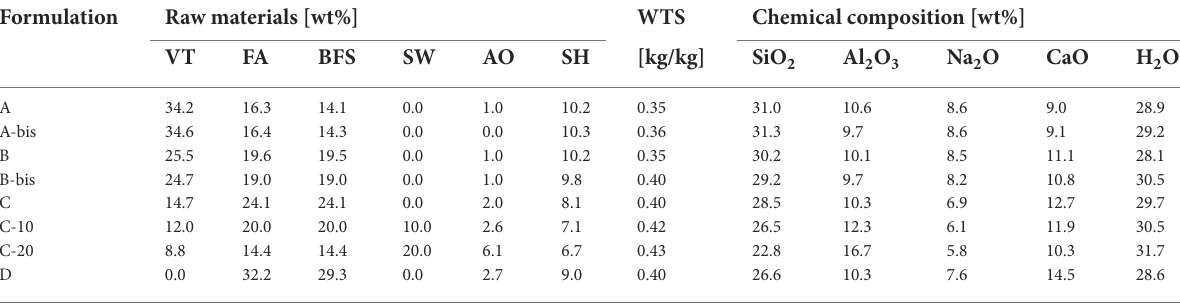
TABLE 2 Overallchemicalcompositionofthegeopolymericformulationsandthecontentsofrawmaterials.